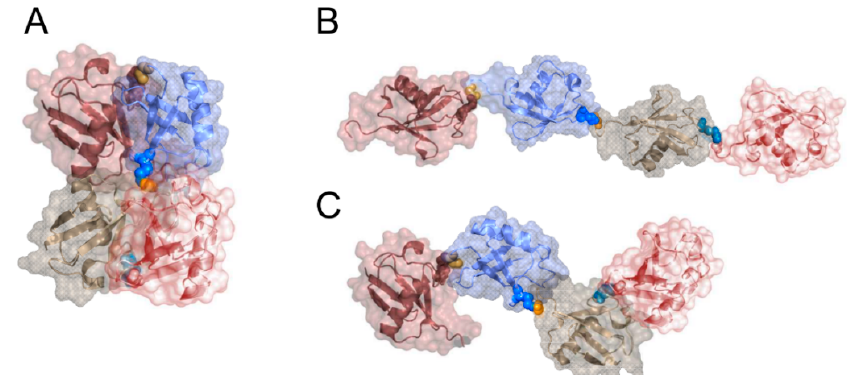
Figure 6. Comparison of different ubiquitin chain structures. Ubiquitin molecules are shown with both cartoon and transparent surface representation. Linking lysine residues are shown as spheres. ( A ) Crystal structure of K48-linked tetra-ubiquitin showing a compact, closed conformation with the hydrophobic patches sequestered in the complex interface (PDB ID: 2O6V); ( B ) Elongated structure of K63-linked tetra-ubiquitin (PDB ID: 3HM3); ( C ) A hypothetical elongated structure of K48-linked tetra-ubiquitin showing that due to the specific linkage type it is less elongated than the extended